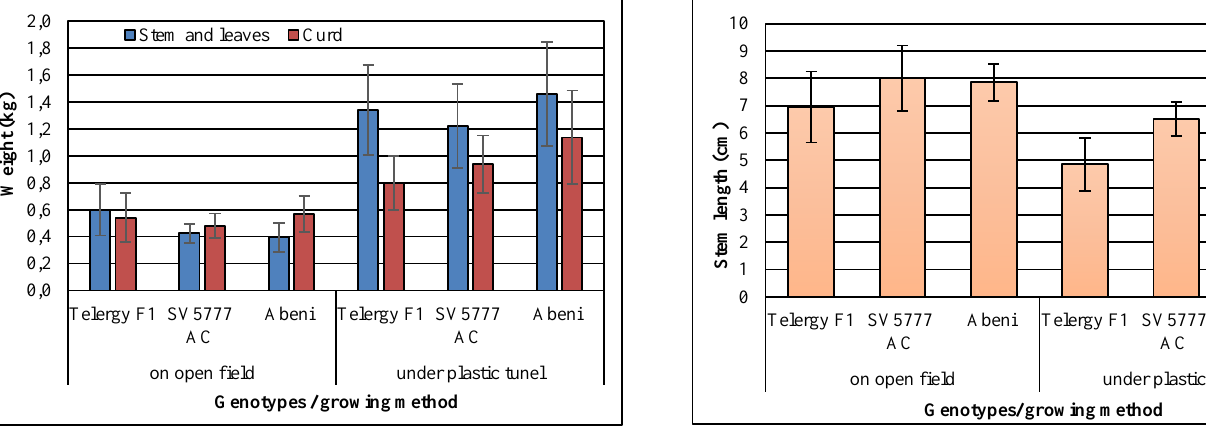
Figure 3. The length of stem in the curd by different genotypes and growing method (n=10; Nagykereki,